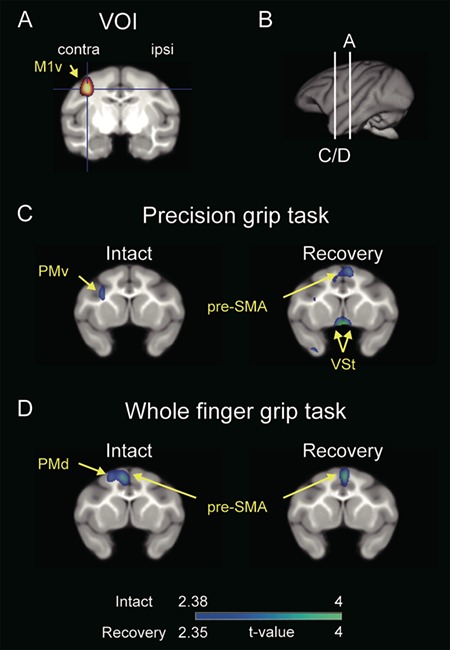
Functional connectivity between the contralesional M1 and VSt during recovery. (A) VOI for the ventral aspect of the contralesional M1 (co-M1v) was determined by the results of the main effect of the functional recovery shown in Figure 3B. VOI of the co-M1v was the entire region of significant functional activation thresholded at P < 0.001 (t > 3.1) consisting of 720 voxels. (B) Lines indicate the levels of coronal sections in A and C/D. (C and D) Coronal sections including the VSt are presented. Brain areas having a significant positive correlation with the co-M1v during (C) precision grip task and during (D) whole finger grip task are indicated on a template brain MRI by a color scale (P < 0.01, uncorrected for multiple comparisons) in the intact stage and the recovery stage. Results show averaged data from the three monkeys. See Supplementary Figure 3 and Supplementary Table 5 for other brain areas showing significant positive correlation with the co-M1. contra, contralesional; ipsi, ipsilesional; M1v, ventral aspect of the primary motor cortex; PMv, ventral premotor area; PMd, dorsal premotor area.